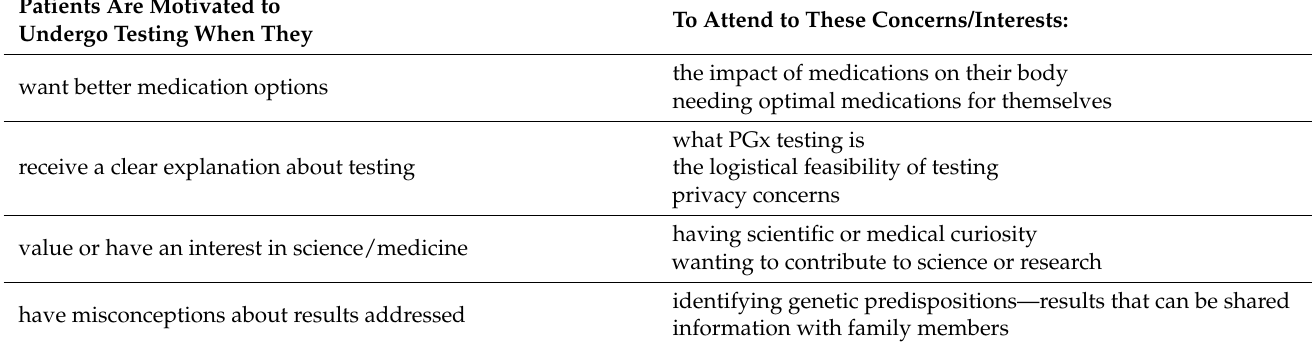
Table 3. Factors to Address in Patient Counseling to Promote PGx Testing